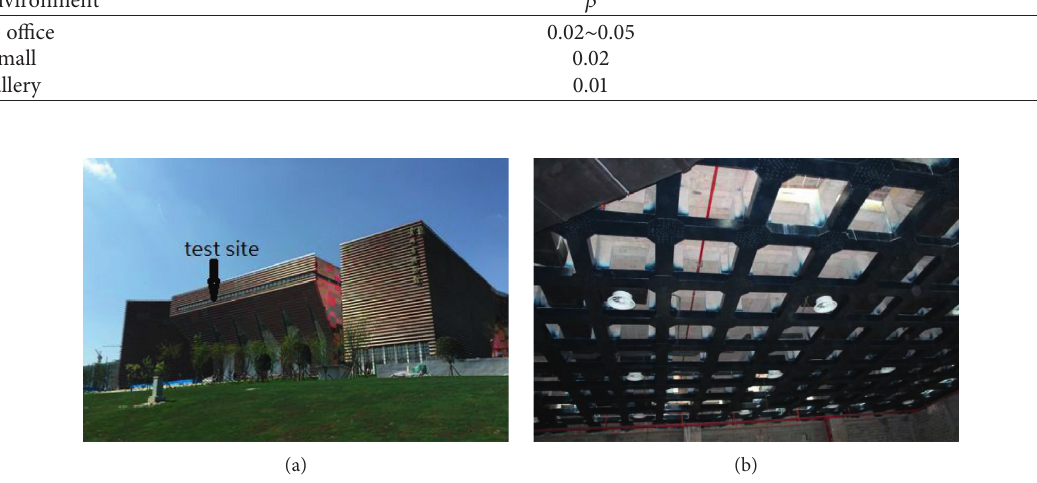
Figure 3: Long-span composite floor: (a) exterior view; (b) interior view.